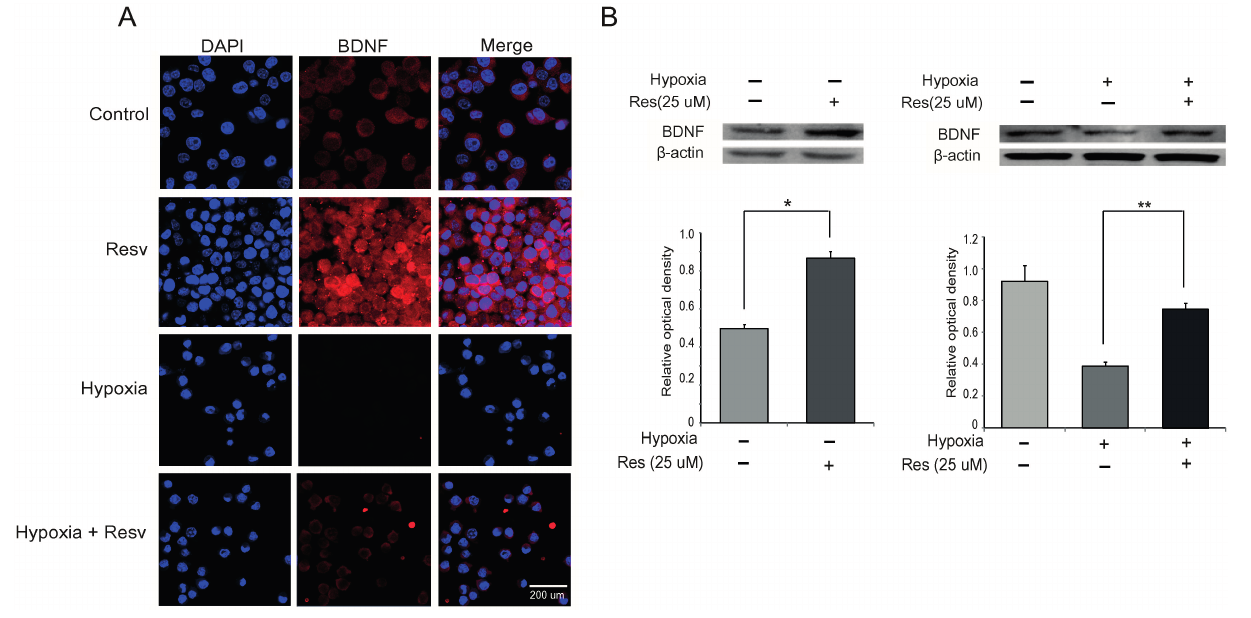
Figure 5. The measurement of BDNF (brain-derived neurotrophic factor) expression by resveratrol in hypoxia injured microglia. ( A ) The expression of BDNF (a neurotrophic factor) was evaluated by immunocytochemistry. This image showed that the expression of BDNF in the hypoxia group exposed to hypoxia injury was attenuated compared to the control group. The resveratrol (25 μ M) treatment group (Resv group) shows that resveratrol (25 μ M) increased the expression of BDNF under normal conditions. Also, the resveratrol (25 μ M) pre-treatment group (Hypoxia + Resv group) showed increases of BDNF expression compared with the hypoxia group; ( B ) Western blotting data showed that the protein level of BDNF was decreased in the hypoxia group compared to the control group. The protein level of BDNF was increased in the resveratrol (25 μ M) treatment group compared to the control group. The protein level of BDNF was increased in the hypoxia + resv group compared to the hypoxia group. β -actin was used as an internal, loading control (mean ± S.E.M., n = 3). * p < 0.05, ** p < 0.01 (compared to the hypoxia group). Control : normal control group, Hypoxia : hypoxia injury group for 4 h, Resv : resveratrol (25 μ M) treatment group under normal condition, Hypoxia + Resv : resveratrol pre-treatment for 3 h. 4',6-diamidino-2-phenylindole (DAPI): blue, Brain-derived neurotrophic factor (BDNF): red, Scale bar: 200 μ